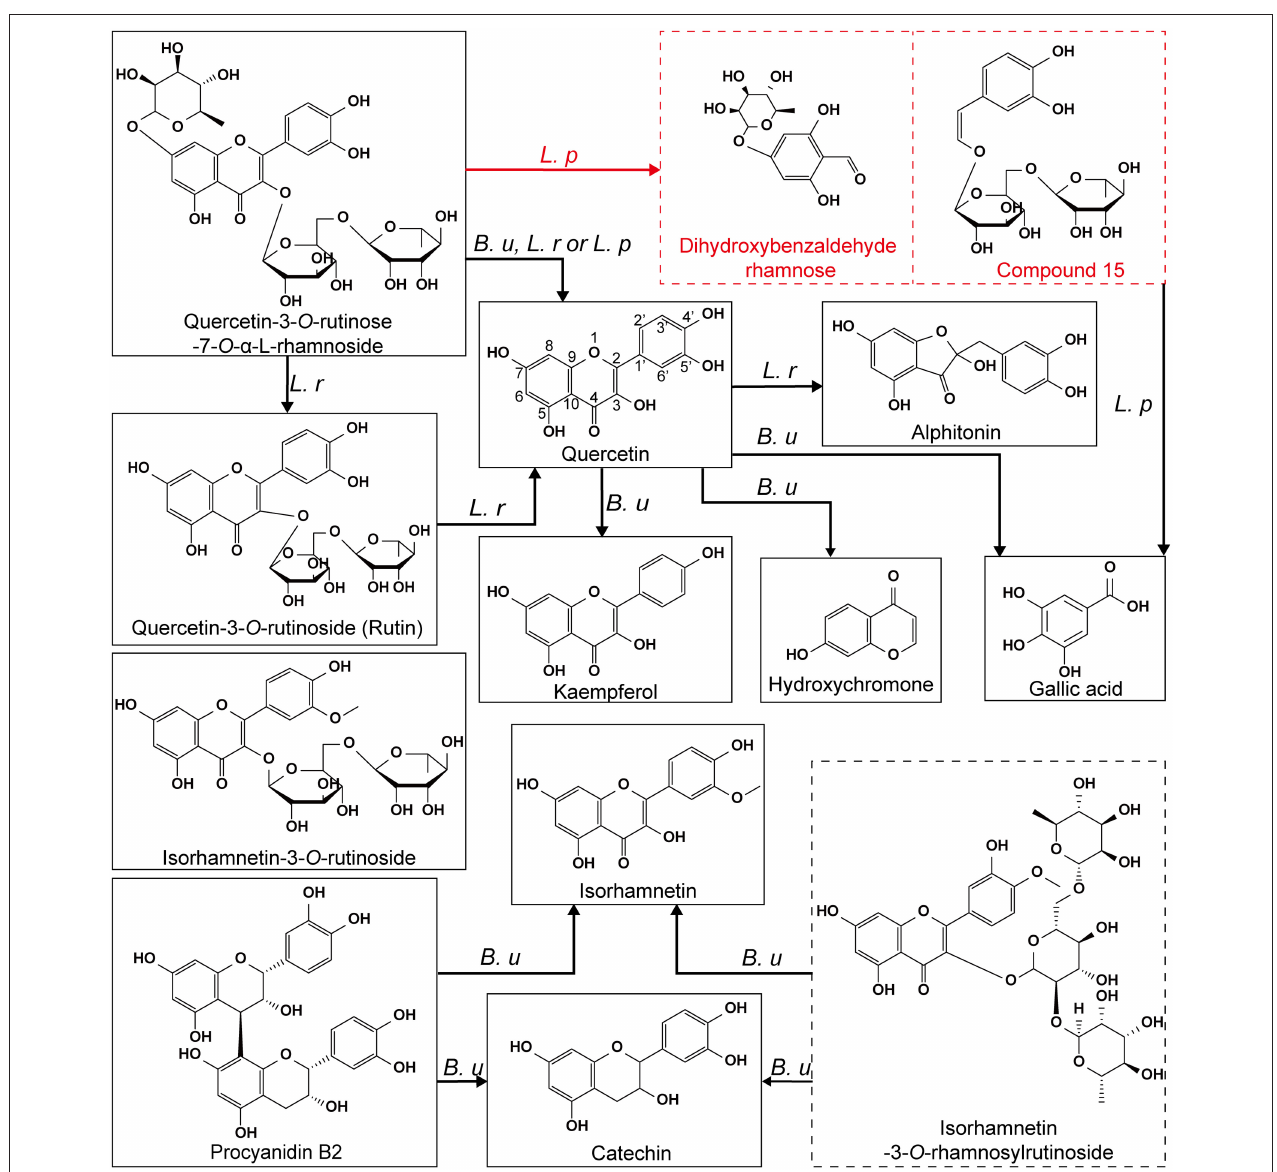
FIGURE 7 | The proposed metabolic pathways of phenolic compounds in LPP by B. uniformis , L. rhamnosus and L. plantarum . The compounds framed with a dashed line represented the metabolites that were not verified. B. u , transformation occurred in the B. uniformis culture; L. r , transformation occurred in the L. rhamnosus culture; L. p , transformation occurred in the L. plantarum